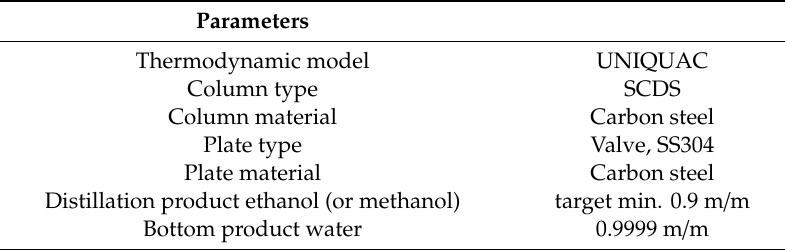
Table 6. Distillation column